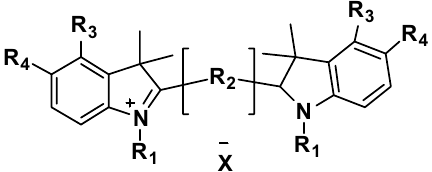
Fig. 1. General formula of heptamethine indocyanine